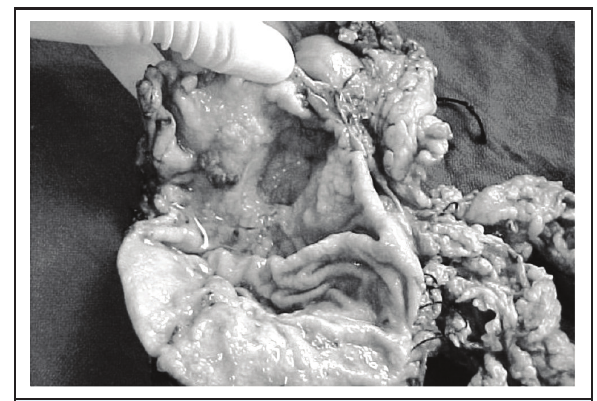
Figure 1. Ulcerative growth with perforation in the antrum.